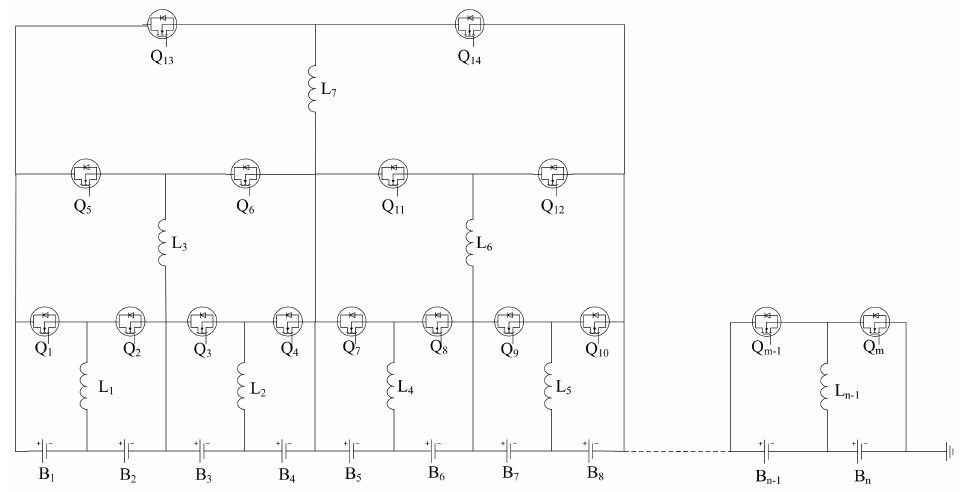
Figure 1. Cascaded Buck-Boost balance